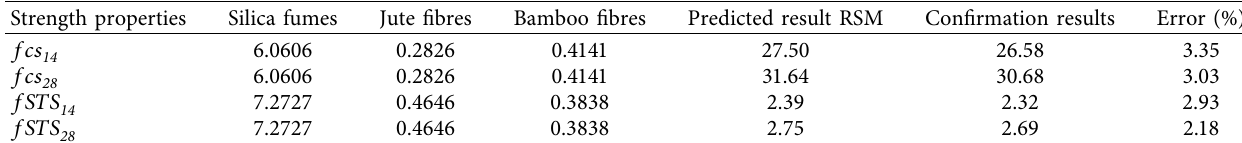
Figure 10: Response optimization plots. (a) Compressive strength. (b) Split tensile strength. Table 7: Confirmation of test results and error